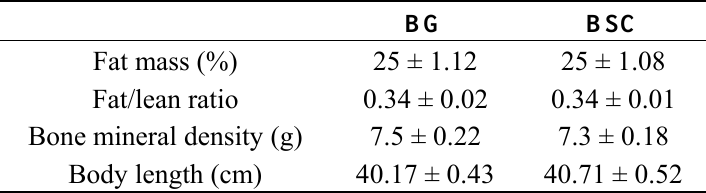
Table 2. Body composition of the rats.